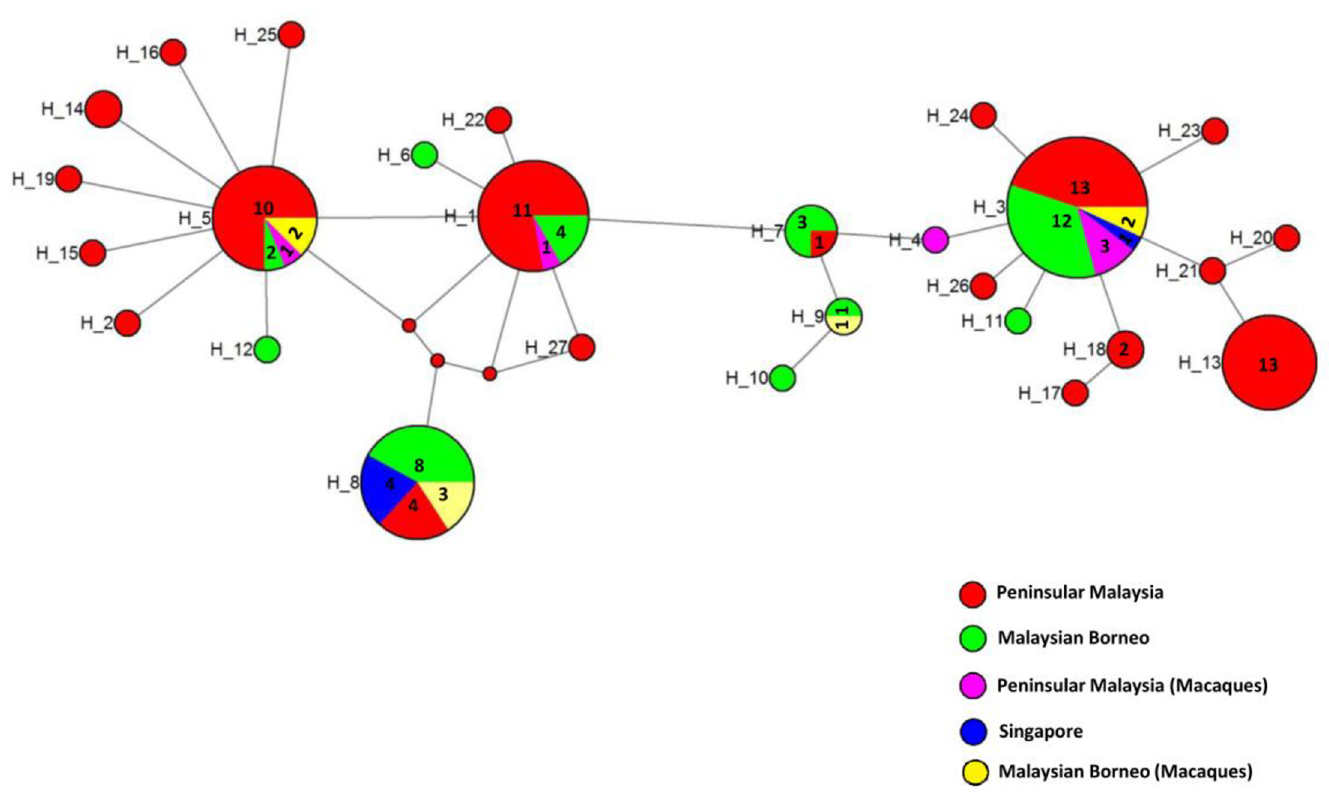
Fig 6. Median Joining Network of CSP generated using Network program. The network shows relationship among the 27 haplotypes based on the human Th2R/Th3R sequences from Peninsular Malaysia, Singapore and macaques from Peninsular Malaysia. Numbers in larger circles represent number of haplotypes, unnumbered circles represent single haplotypes. The smaller red circles are median vectors generated by the program.